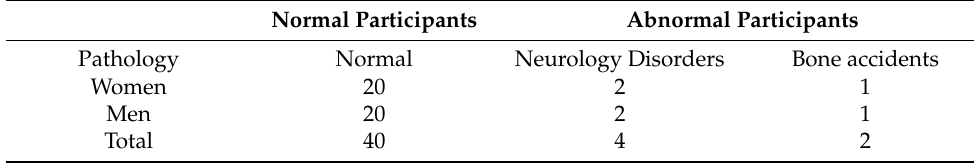
Table 1. The participants’